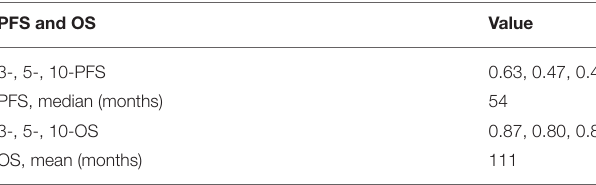
TABLE 2 | PFS and OS of 33* meningioma